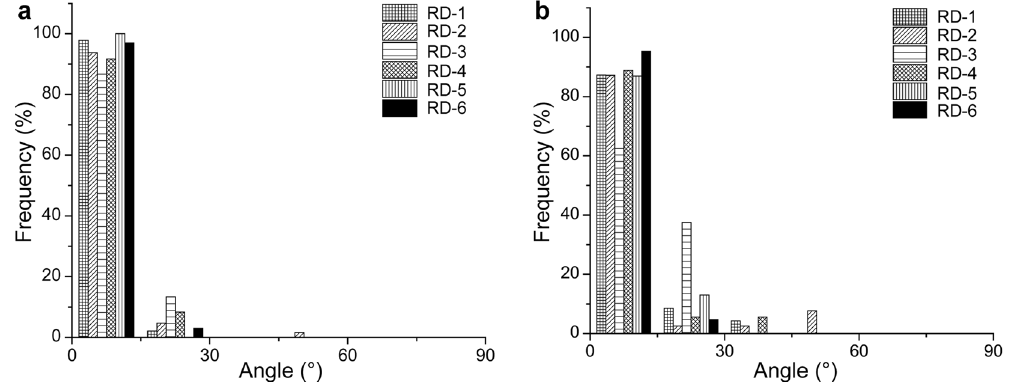
Figure 4. Localized similarities between the direction of collagen and elastic fibers. Histograms show local differences between the orientation angles of collagen and elastic fibers in the superficial reticular dermis ( a ) and the deep reticular dermis ( b ) (x-axis interval, 15°). RD-1 to RD-6 indicate six skin